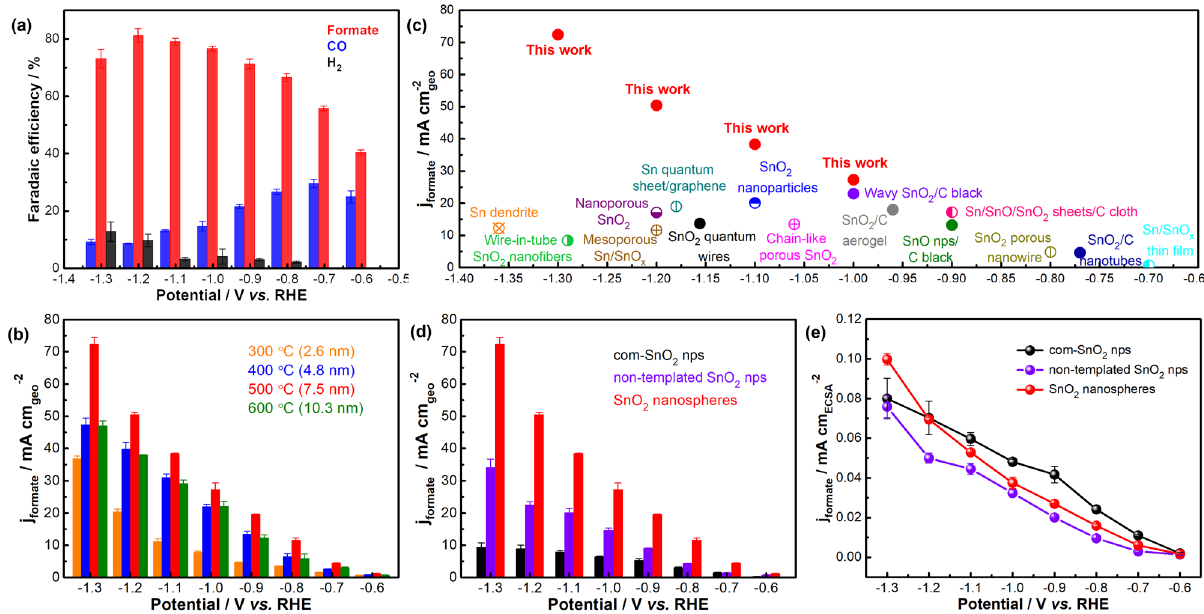
Figure 2. ( a ) Representative Faradaic efficiency for formate, CO, and H 2 vs. cathodic potentials for SnO 2 nanospheres calcined at 500 °C. ( b ) Potential-dependent formate partial current density as function of calcination temperature of SnO 2 nanospheres (aka SnO 2 crystallite size). ( c ) Comparison of CO 2 RR performance for the best-performing SnO 2 nanospheres with previously reported Sn, SnO 2 and SnO 2 -carbon electrocatalysts tested in a H-cell with bicarbonate electrolyte (mixed metal oxides, alloys, and doped systems are excluded): Sn dendrite 12 , nanoporous SnO 2 15 , SnO 2 porous nanowires 16 , chainlike mesoporous SnO 2 18 , Sn/SnO x thin film 20 , Sn/SnO/SnO 2 nanosheets/carbon cloth 21 , wire-in-tube SnO 2 nanofibers 22 , SnO 2 nanoparticles 23